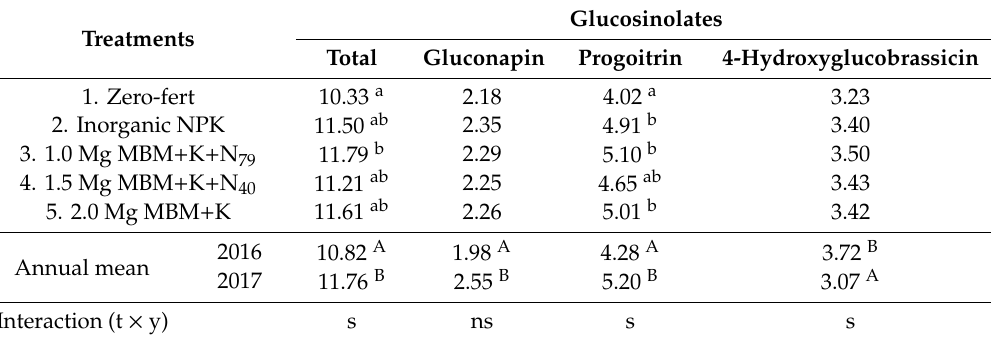
Interaction (t × y) s ns